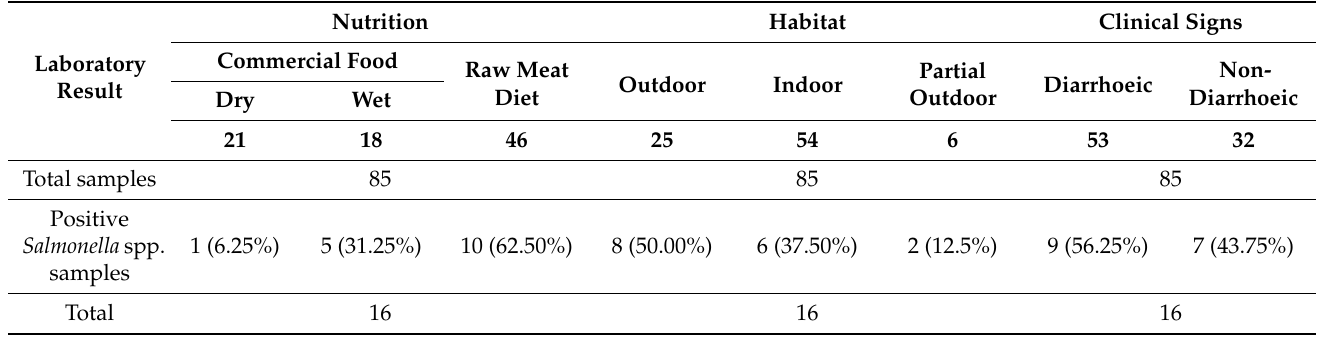
Table 4. Distribution of cat Salmonella spp. positive faecal samples, according to diet, habitat, and clinical aspects. Nutrition Laboratory